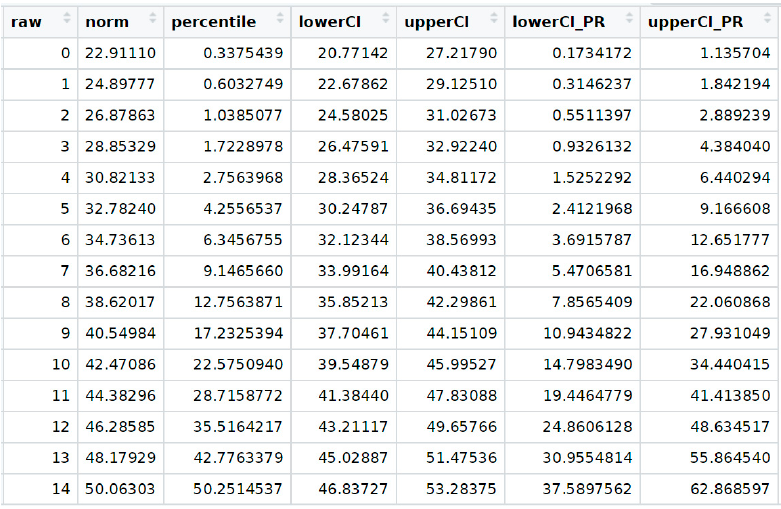
Figure 11. Raw table for grade level 3.0.